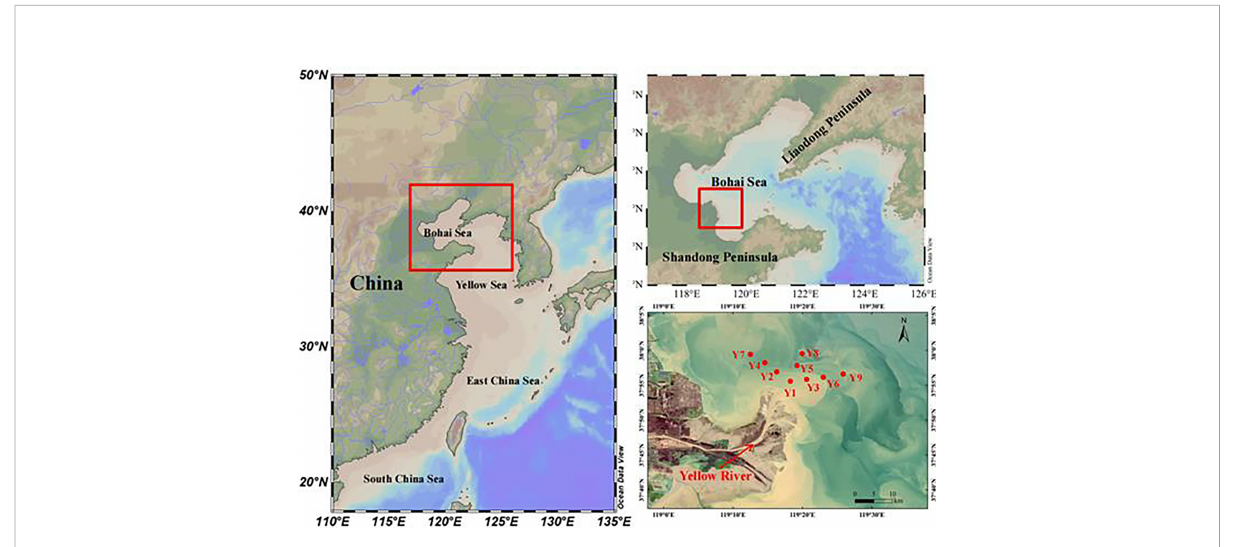
FIGURE 1 Location of sampling sites in the study